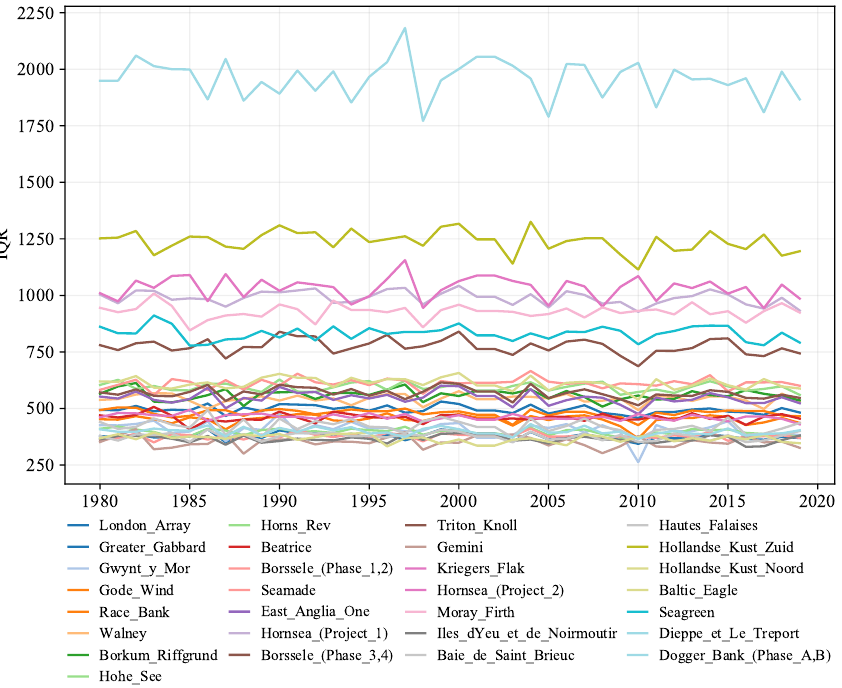
Figure A5. Interquartile range of all wind farms from 1980 to 2019. Every line illustrates the yearly interquartile range (IQR) of one wind farm.